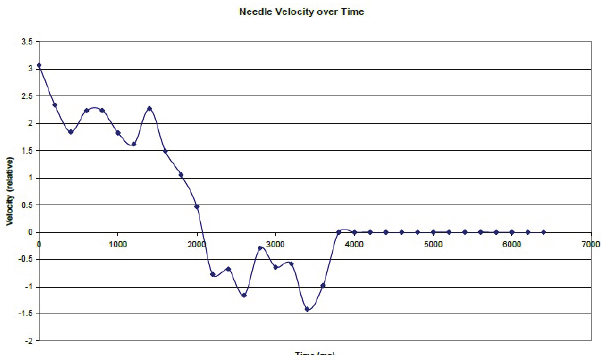
Figure 14: Needle vector velocity during VP process derived from a video recording of a typical venepuncture